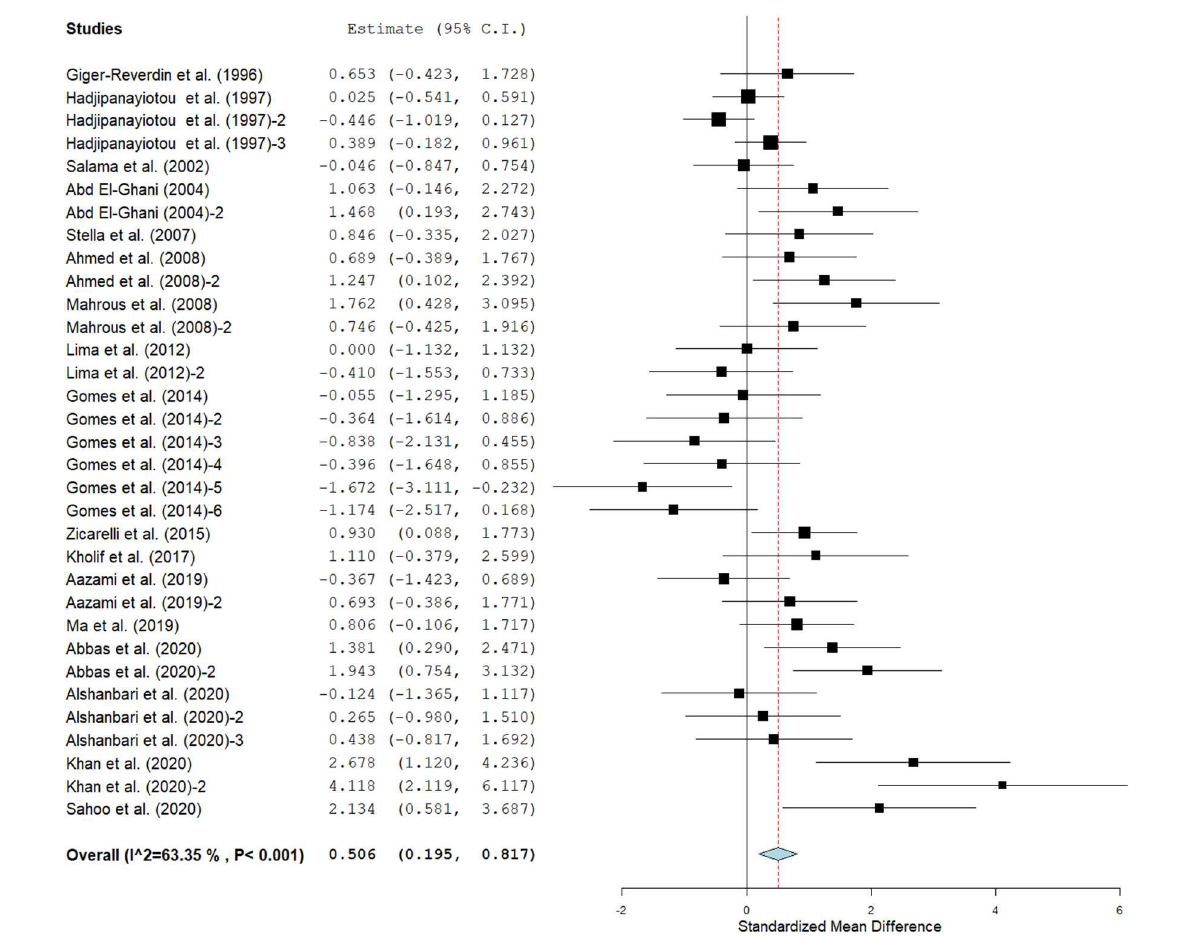
FIGURE3 Forest plot of the impact of SC on milk yield in lactating goats. The error bars connote the SMD of each trial, while the upper and lower 95% CIs for the effect size are the line that joined the individual square box. The thick vertical line is the line of no effect (SMD = 0), which suggests no effect of SC supplementation on milk yield. The sky-blue diamond at the base of the plot indicates the pooled SMD with its width representing the 95% confidence intervals for the effect size. The points to the right of the line of no effect suggest an increase in milk yield. The points to the left of the line of no effect connote an increase in milk yield. I 2 is the inconsistency index.